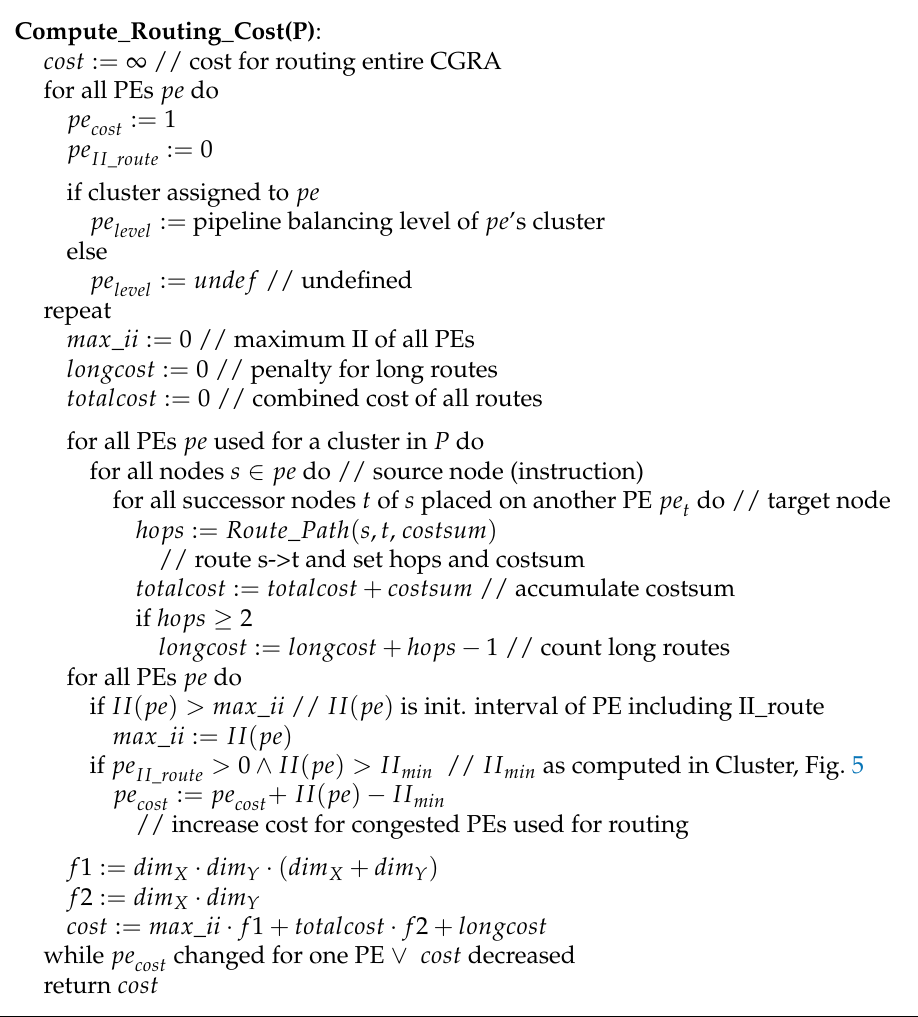
Figure 9. Congestion-based routing algorithm Compute_Routing_Cost .